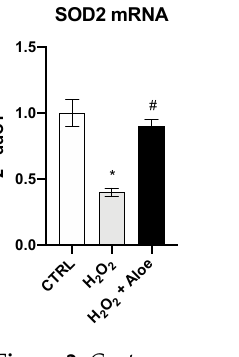
F Figure 2. Cont